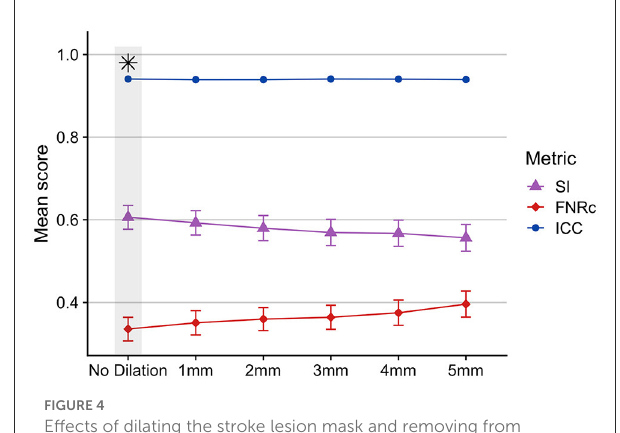
FIGURE4 Effects of dilating the stroke lesion mask and removing from BIANCA output as a potential method to control for false positive WMHs around the boundaries of the stroke lesion. BIANCA performance decreased with increasing size of stroke lesion dilations, and the best BIANCA performance was achieved when stroke lesions were not altered in size. This indicates BIANCA did not identify significant numbers of false-positive WMHs around the boundaries of stroke lesions. This step was performed after BIANCA parameter optimization too fine-tune BIANCA model output (optimized BIANCA parameters). Gray bars and black asterisks indicate the best-performing